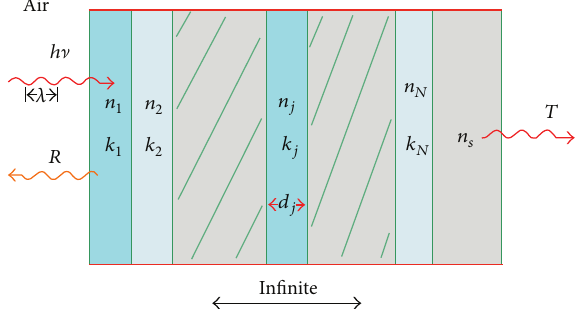
Figure 1: Schematic diagram of the optical model for stacked films.